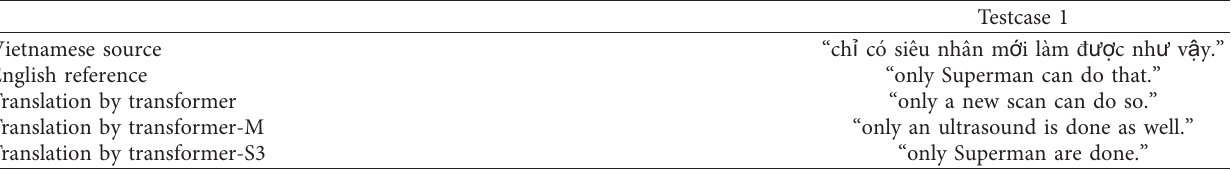
Table 8: Translations of a Vietnamese sentence comprising 15 tokens.